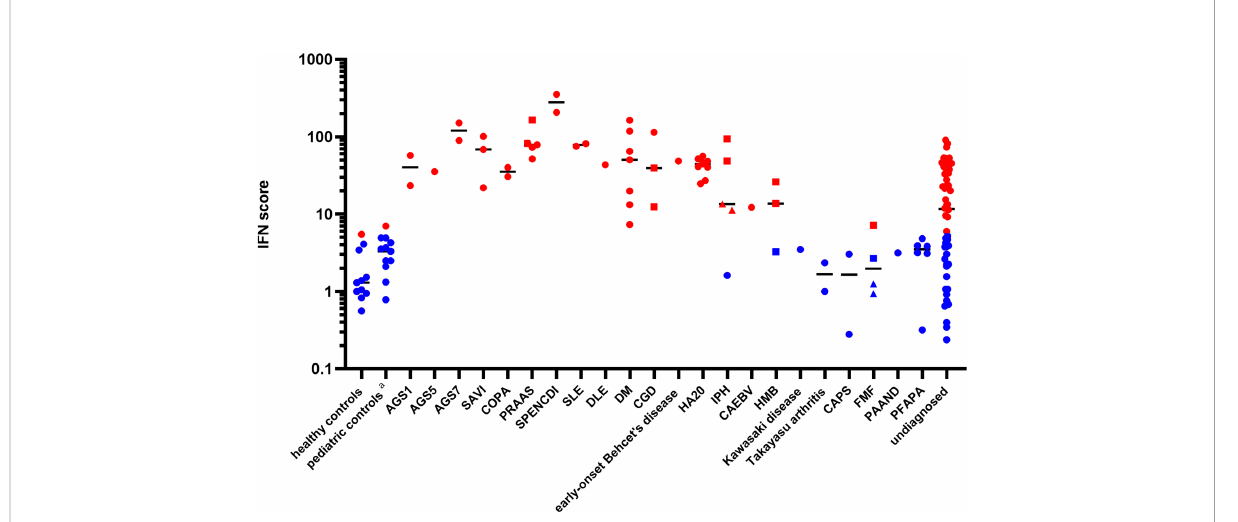
FIGURE 1 Patient interferon scores according to disease diagnosis. Red dots represent ISs greater than 5.04, while blue dots represent ISs below 5.04, based on two standard deviations from the mean score found in healthy controls. The circles represent the ISs of the different subjects, except for those of the “ undiagnosed ” patients with a high IS. The squares and triangles represent repeat samples from the same subjects, respectively. Details of the ISs of the “ undiagnosed ” patients with a high IS are described in Table 2. Black horizontal lines represent the median for each patient group. DLE, discoid lupus erythematosus; CAEBV, chronic active Epstein-Barr virus infection; HMB, hypersensitivity to mosquito bites; FMF, familial Mediterranean fever; PAAND, pyrin-associated autoin fl ammation with neutrophilic dermatosis; PFAPA, periodic fever, aphthous stomatitis, pharyngitis, cervical adenitis. The pediatric controls include asymptomatic pediatric patients with nonin fl ammatory diseases such as congenital heart disease and hydronephrosis who attended a hospital for a routine